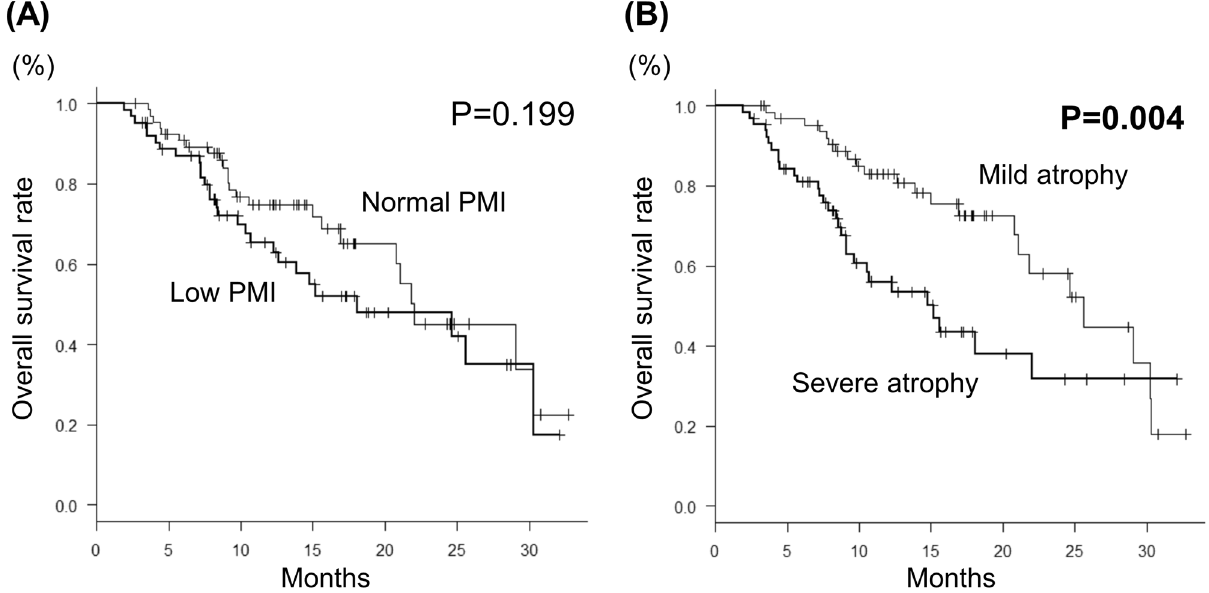
Figure 2. Kaplan–Meier curves for overall survival in the low and normal PMI groups ( A ) and in the severe and mild atrophy groups ( B ). Variable